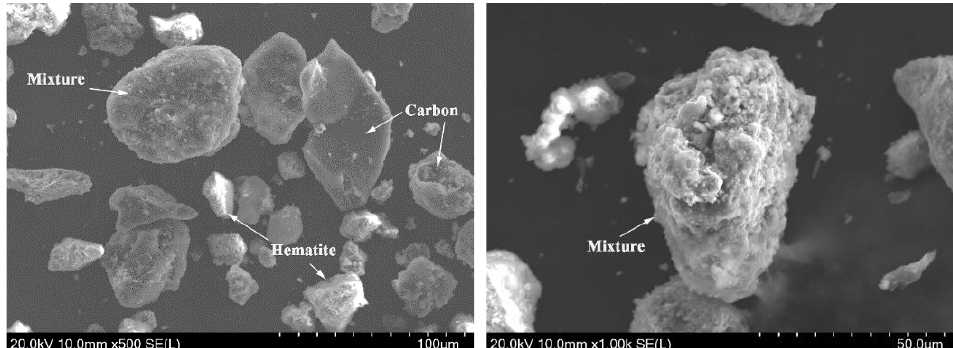
Figure 2. Morphology of BF particles under SEM (carbon, hematite, and mixture particles were detected by EDS).